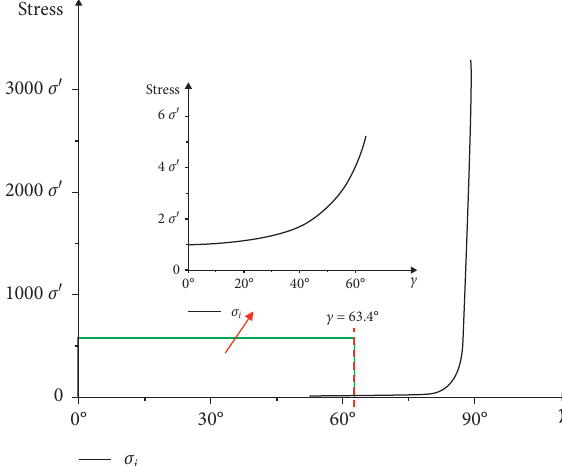
Figure 14: The changes in normal stress σ